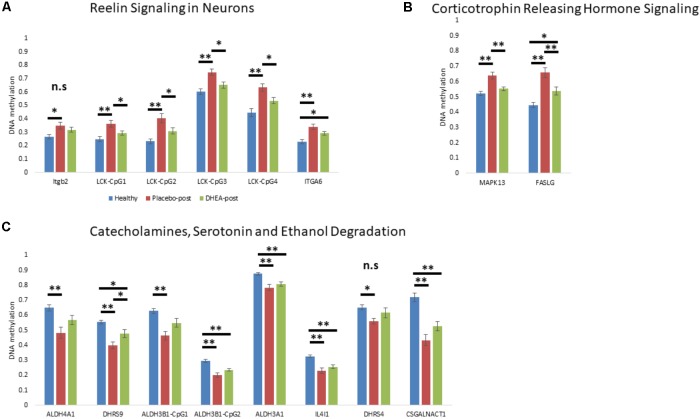
The effect of DHEA intervention on neurobiological-related gene promoters. (A) Gene promoters hypermethylated in addicts and related to the “Reelin Signaling in Neurons” pathway. (B) Gene promoters hypermethylated in addicts and related to the “Corticotrophin Releasing Hormone Signaling” pathway. (C) Gene promoters hypomethylated in addicts and related to the “Catecholamines, Serotonin, and Ethanol Degradation” pathway. Methylation values were determined using Illumina 450K arrays. Statistical significance was determined using one-way ANOVA analyses followed by Bonferroni correction for multiple testing and Tukey post hoc test. ∗p < 0.05, ∗∗p < 0.01, n.s.- ANOVA did not stand Bonferroni correction (p > 0.05 for the main effect).